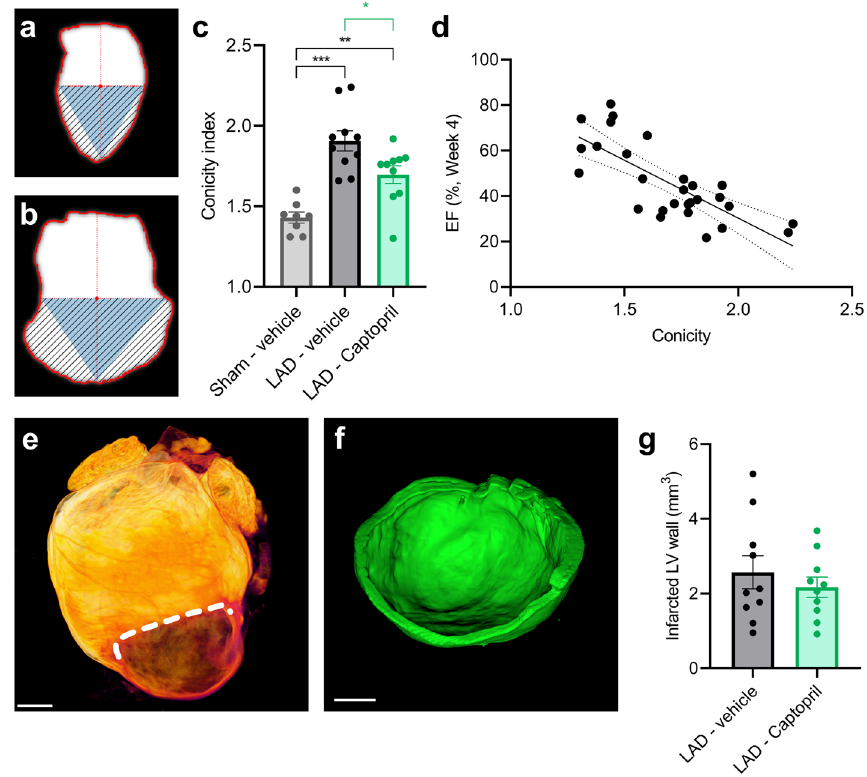
Figure 3. Light sheet analysis of ventricular wall dilation and infarct size. ( a ) Schematic illustration of apical conicity index calculation in Sham—vehicle heart. The index represents the ratio between the fitted triangle and striped area. ( b ) Same as above but shown for LAD—vehicle heart. Left ventricle (LV) wall dilation leads to increased area outside the fitted triangle. ( c ) Statistical comparison of cardiac conicity index. ( d ) Ejection fraction (EF) at week 4 shows negative correlation to conicity index (r = -0.76; p < 0.0001). ( e ) Representative example of light sheet imaged heart with infarct zone separated by line. ( f ) Segmented volume of cardiac wall with thickness below 400 µm (from sample shown in E). ( g ) Quantification of infarcted LV wall volume with thickness below 400 µm. Significance: *p < 0.05, **p < 0.01, ***p < 0.001. Scale bars: 1 mm. LAD: left anterior descending artery